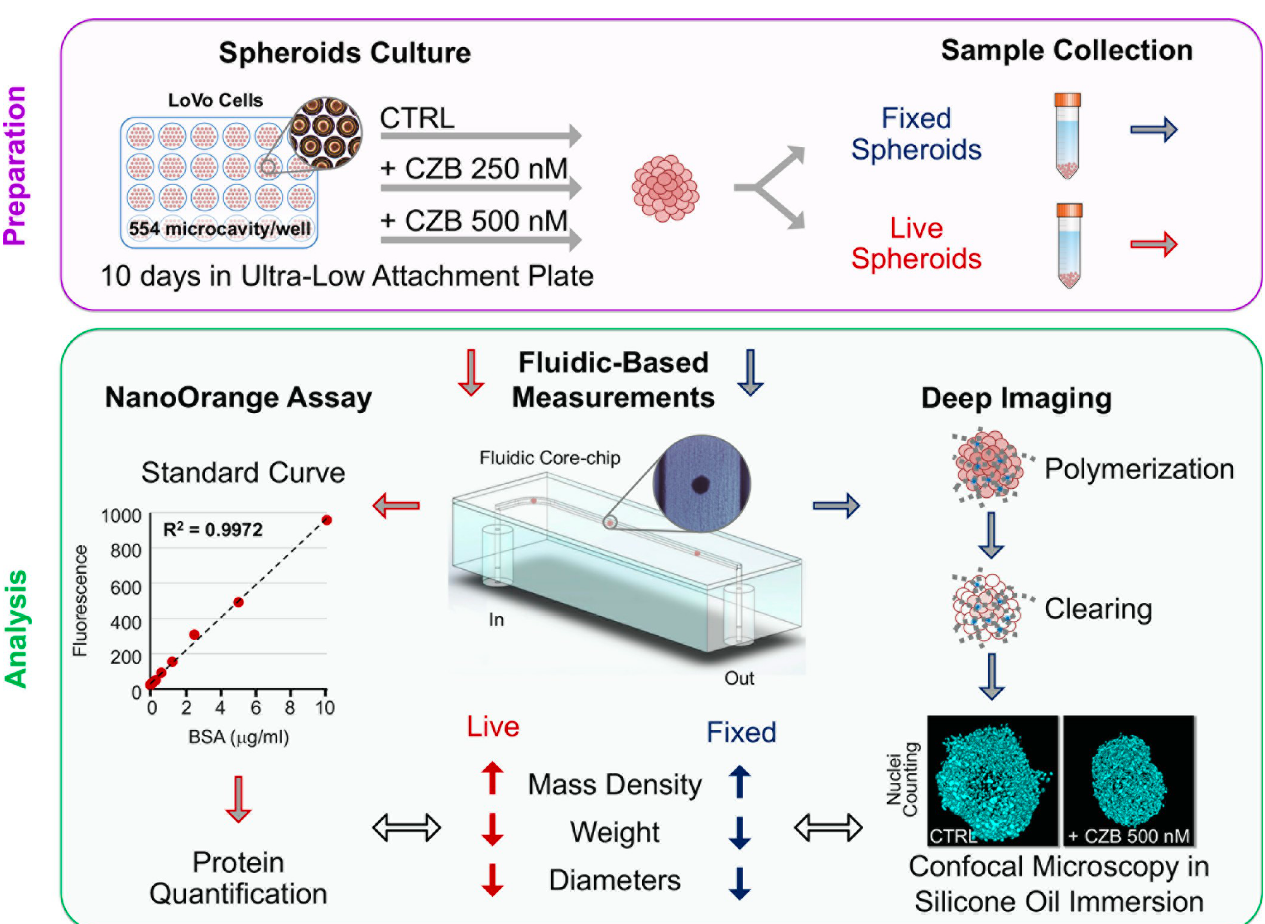
Fig 1. Scheme of the research strategy. Experimental outline of the research work, from spheroid culture and treatment with CZB to setting up the analyses on fixed and live samples. The LoVo cells were cultured in Ultra-Low Attachment Microcavity Plate in presence of 250 and 500 nM of CZB. At 10 days fully mature and organized spheroids were harvested, for the analysis procedures. Live and fixed samples were evaluated with a new fluidic device (W8) for the accurate, simultaneous, and rapid measurement of mass density, weight, and size. These parameters were correlated with protein quantification (NanoOrange Assay) and deep imaging analysis performed on clarified